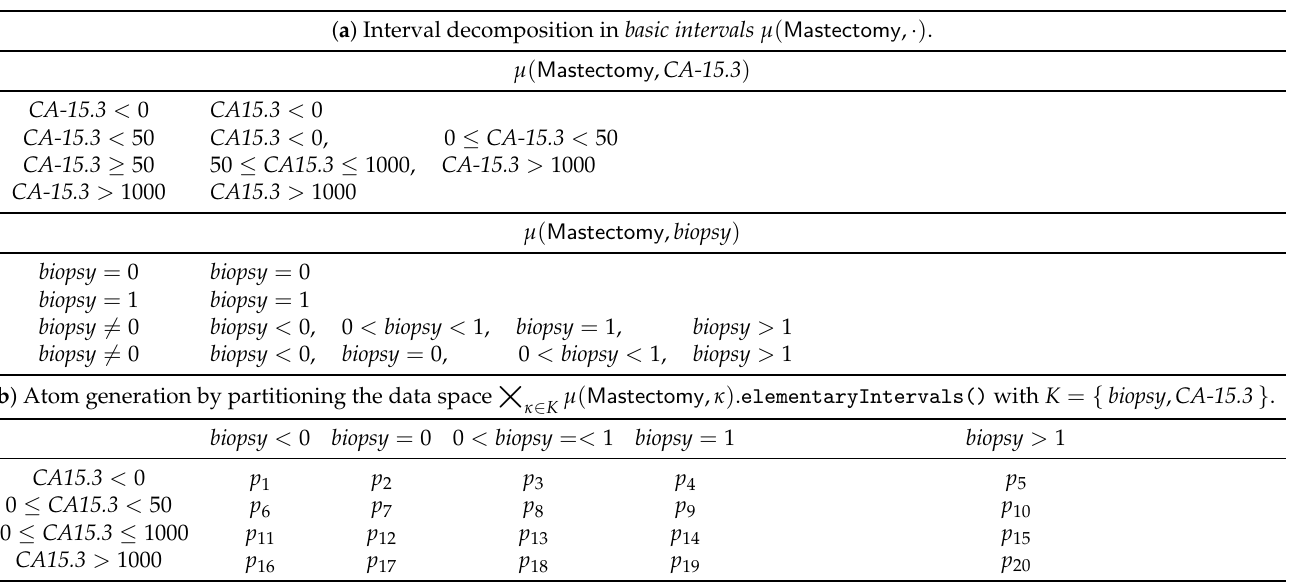
Table 3. Intermediate steps to generate distinct atoms for the Referral data predicates from Example